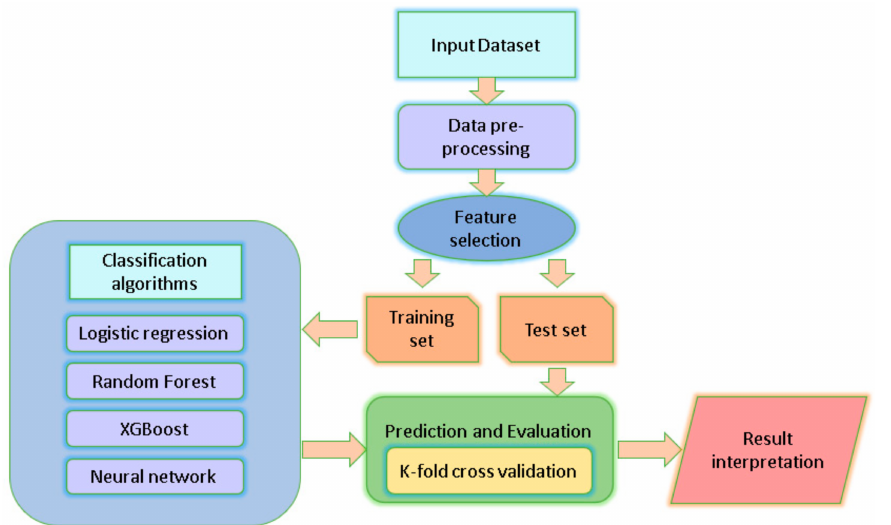
Figure 1. Computational methods. Schematic workflow for the construction of classification mod- els including feature selection, cross-validation to evaluate the discriminant performance, and resulting